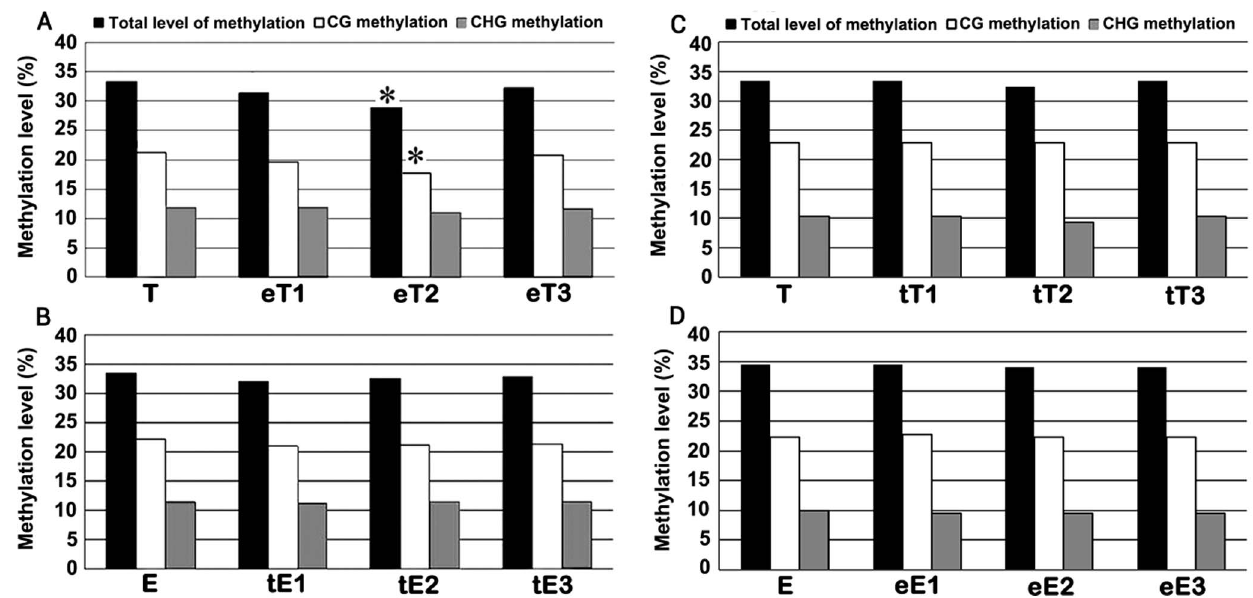
Figure 1. Tabulated data of relative DNA methylation levels based on the MSAP analysis. Relative levels of total, CG and CHG methylation at randomly sampled 5 9 -CCGG sites by the MSAP marker, in three independent tomato scions hetero-grafted to eggplant (marked as eT1-3) ( A ), three independent eggplant scions hetero-grafted to tomato (marked as tE1-3) ( B ), three independent self-grafted tomato scions (marked as tT1-3) ( cC ), three independent self-grafted eggplant scions (marked as eE1-3) ( D ),and their respective seed-plant controls of tomato (T) and eggplant (E), respectively. * Values significantly lower than the values of the corresponding seed-plant controls ( P , 0.05).